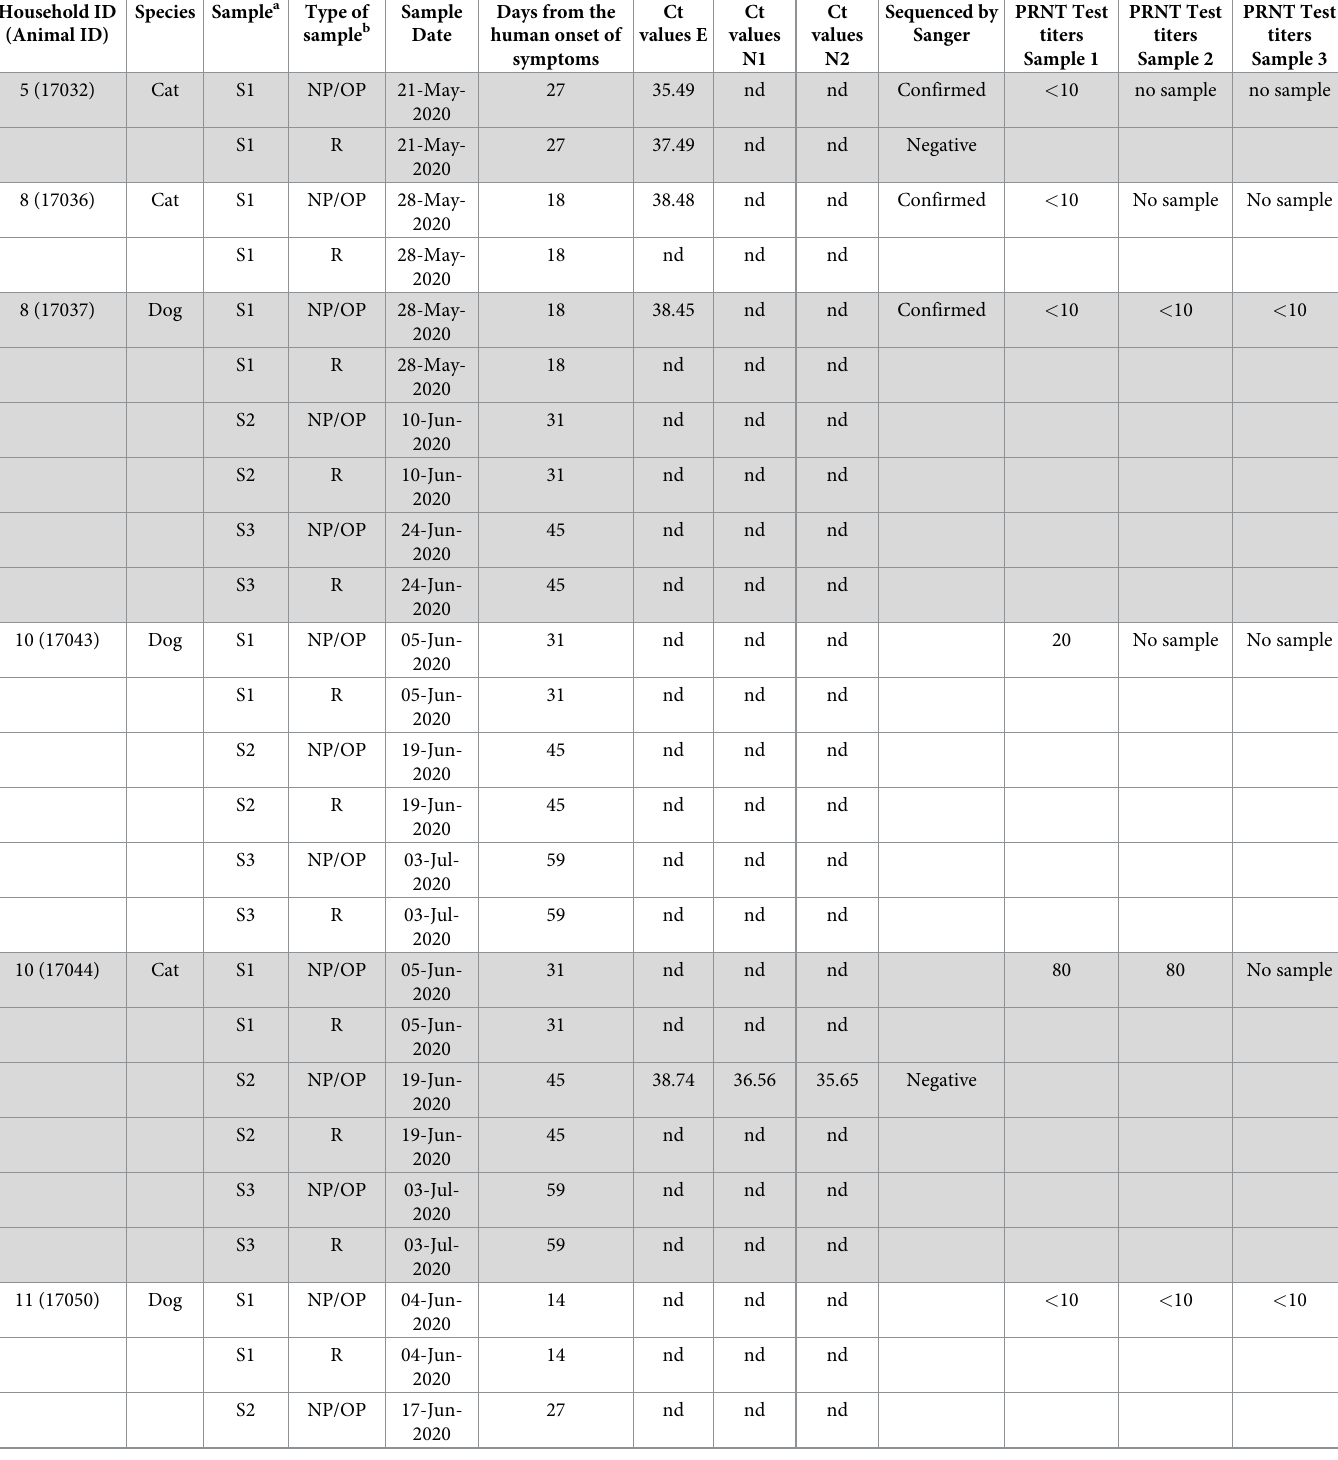
Table 1. Dogs and cats that tested positive for SARS-CoV-2 by real-time RT-PCR and/or sequencing by Sanger method and tested seropositive for antibodies by plaque reduction neutralization test, between May 2 nd , 2020 and October 7 th , 2020 (metropolitan region of the state of Rio de Janeiro, Brazil). Household ID (Animal